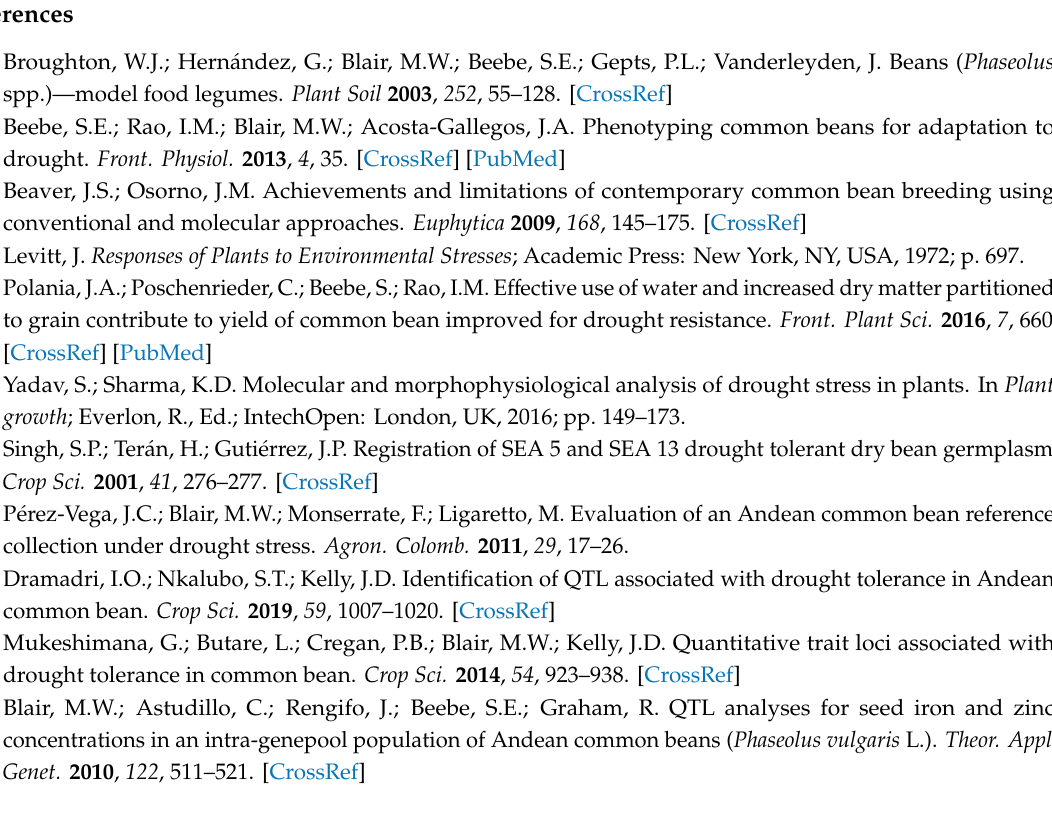
Table S1. QTLs for leaf water potential (Wp), e ff ective quantum yield of PSII ( Φ PSII), days to flowering (Df), days to pod-setting (Dp), number of pods per plant (Pp), number of seeds per pod (Sp), seed yield per plant (Syp), 100 seed mass (Hsm), and pod harvest index (Phi) in two seasons for drought and control for the common bean RIL mapping population. Table S2. Identification numbers used in our study for previously reported Phaseolus vulgaris QTLs with known positions on the consensus linkage map [39]. Table S3. Descriptive statistics for measured physiology-associated, phenological, and yield traits in the RIL population for both seasons and di ff erent experiment conditions. Figure S1: Outside temperatures (max, min) and rainfall distribution at greenhouse experiment station location during two successive years. Figure S2: Common bean linkage groups Pv03 to Pv11 showing QTLs for physiology-associated traits, phenological traits, and yield-associated traits. Figure S3: QTLs for physiology-associated traits, phenological traits, and yield-associated traits on the integrated genetic map of the ‘Tiber’ × ‘Starozagorski’ recombinant inbred line population and common bean consensus map reported by Galeano et al. [39]. Figure S4: Comparison of the order and distance between the SSR and AFLP loci of ‘Tiber’ × ‘Starozagorski’ map, reference map [39], and the projected map for linkage groups 1-6. Figure S5: Comparison of the order and distance between the SSR and AFLP loci of ‘Tiber’ × ‘Starozagorski’ map, reference map [39], and the projected map for linkage groups 7–11. Figure S6: Number of positive alleles for QTLs with high additive e ff ects in both directions observed in top and bottom 10% of values for individual